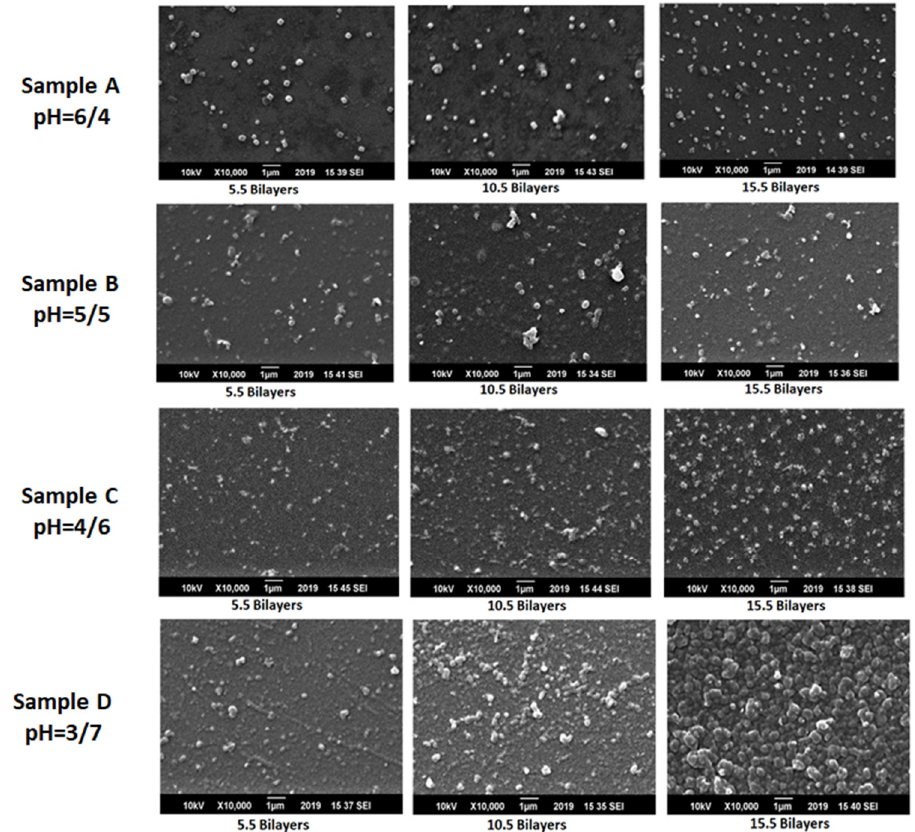
Figure 10. SEM micrographs of thin film gradients of samples A, B, C and D fabricated at various pH combinations.